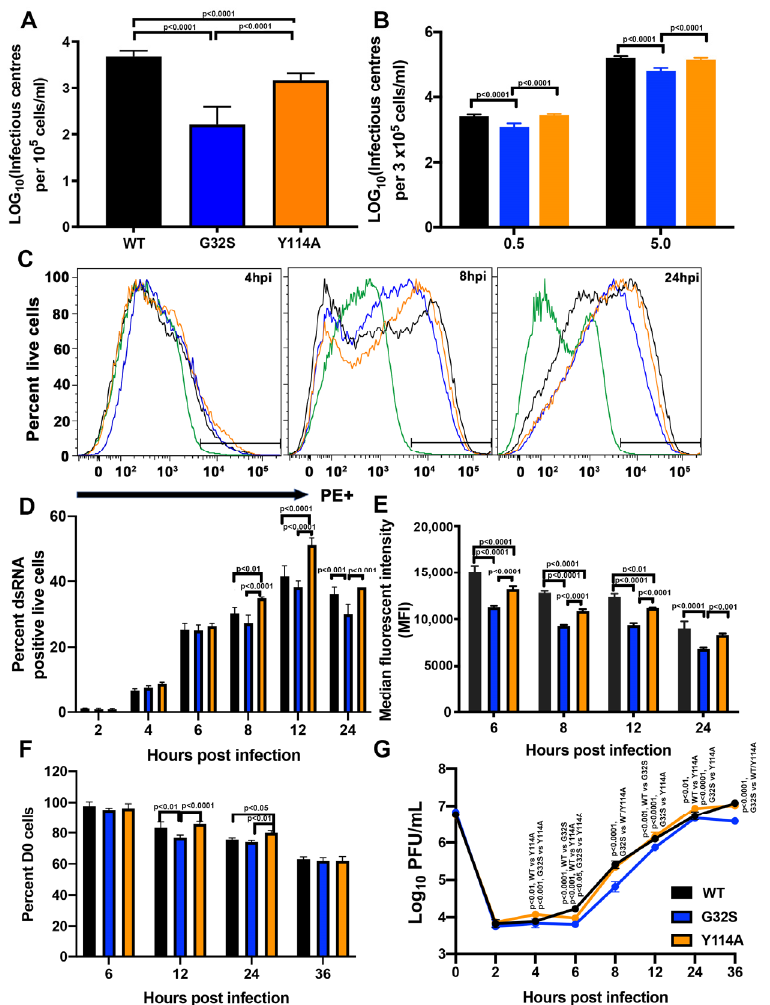
Figure 2. Effect of nsP3 MD mutations affecting ADPr-binding and hydrolase activities on initiation of infection and amplification of replication complexes in C8-D1A cells. ( A ) Infectious center assays for C8-D1A cells (10 5 cells) electroporated with 10 µ g of viral RNA of CHIKV 181/25 (WT) or nsp3 MD mutants G32S and Y114A. Electroporated cells were plated onto subconfluent BHK-21 cells and overlaid with bacto agar to identify virus-producing cells by plaque formation at 48 h. ( B ) Infectious center assays for C8-D1A cells infected with WT (black) or nsP3 MD mutants G32S (blue) and Y114A (orange) at MOIs of 0.5 and 5, incubated an hour at 4 ◦ C and then 37 ◦ C for 4 h. Cells were trypsinized, serially diluted, plated on Vero cells, and overlaid with bacto agar to assess plaque formation at 48 h. Data are presented as log 10 infectious centers per 10 5 cells and represent the mean ± SD from three independent experiments. ( C ) Representative histograms showing the formation and amplification of replication complexes in C8-D1A cells infected with WT (black) and nsP3 MD mutants G32S (blue) and Y114A (orange). Cells were infected at an MOI of 5, live/dead stained, fixed, permeabilized, and stained for dsRNA with J2 mAb and analyzed by flow cytometry. Green line indicates uninfected cells. ( D ) The percentages of live cells positive for dsRNA were quantified and compared at each time point and data presented as a bar graph. ( E ) Median fluorescent intensities presented as the mean ± SD from two independent experiments. ( F ) Cells infected with CHIKV WT, G32S and Y114A mutants at an MOI 5 were counted and cell viability was determined by trypan blue exclusion at 6, 12, 24 and 36 h after infection. ( G ) Supernatant fluids were collected, and infectious virus produced was determined by plaque formation. The data are presented as the mean ± SD from three independent experiments each performed in triplicate. p values indicate the significance of differences between WT and G32S/Y114A or between G32S and Y114A at the indicated time